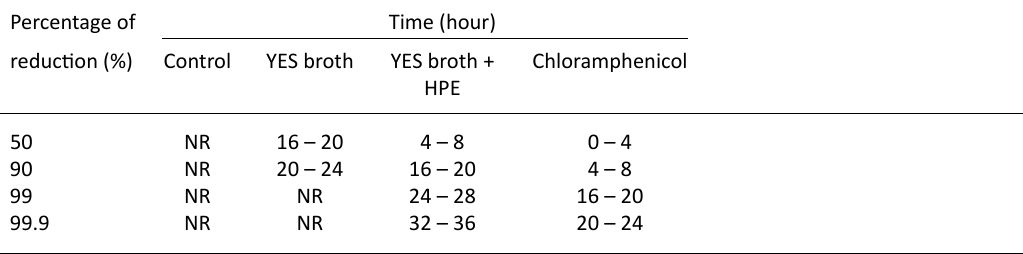
Table 3. The time to achieve 50, 90, 99, and 99.9% growth reduction in initials inoculum of MRSA ATCC33591 Percentage of